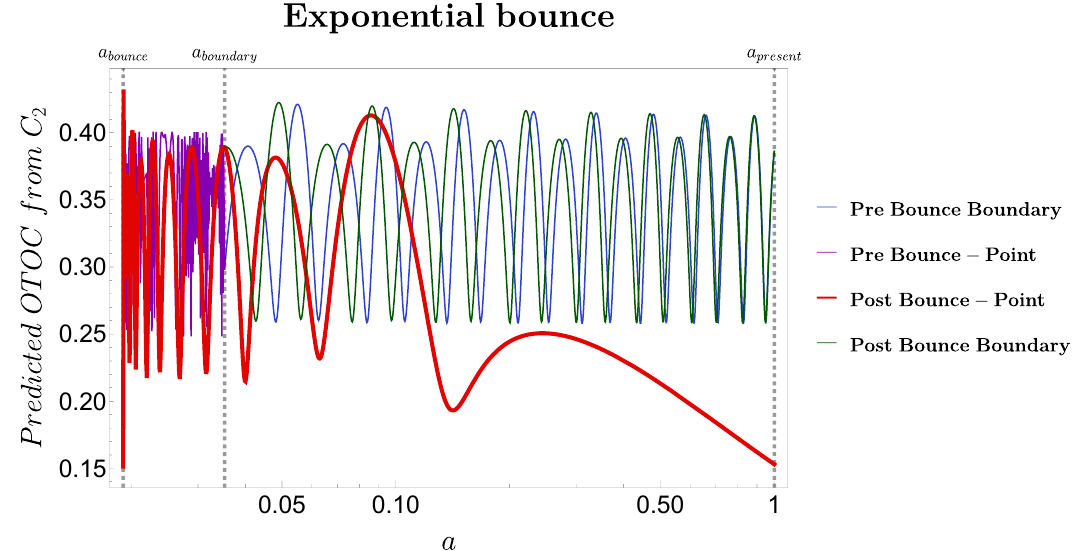
Figure 34: Predicted OTOC from geodesically weighted complexity in different re- gions against scale